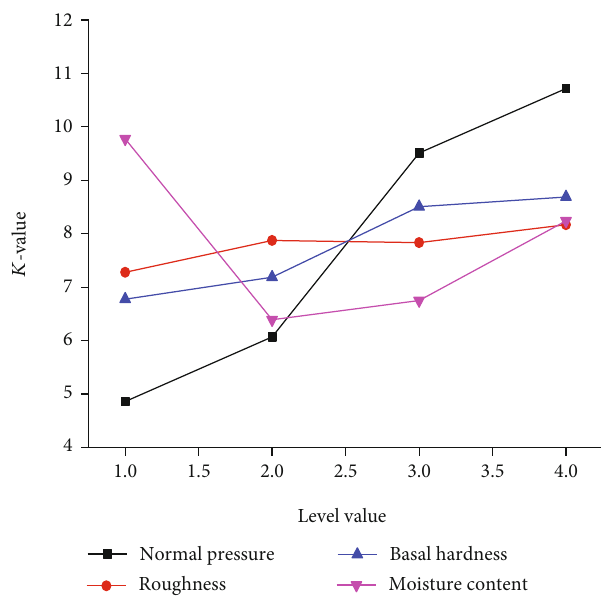
Figure 8: Relationship between the initial shear sti ff ness and the in fl uence of factors.